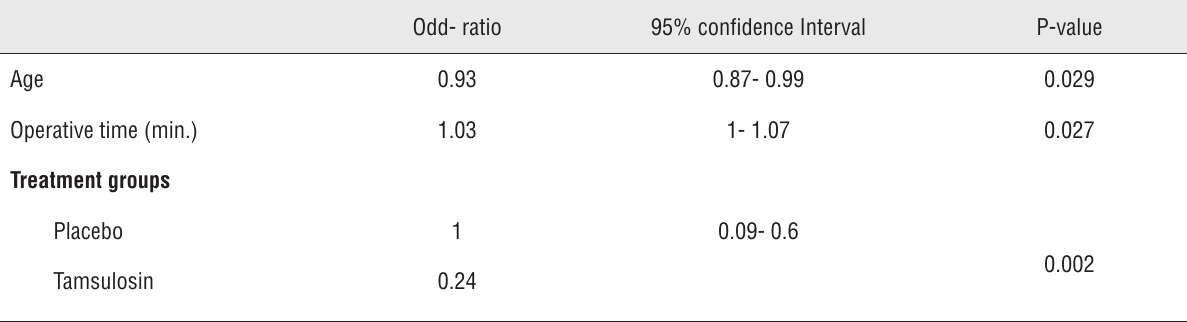
Table 3 - Adjusted odd ratio for treatment group and potential risk factors of POUR. Odd- ratio 95% confidence Interval P-value Age 0.93 0.87- 0.99 0.029 Operative time